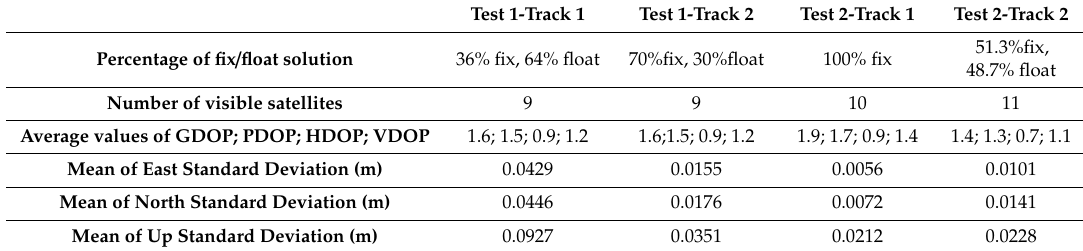
Table 7. CDGPS operative